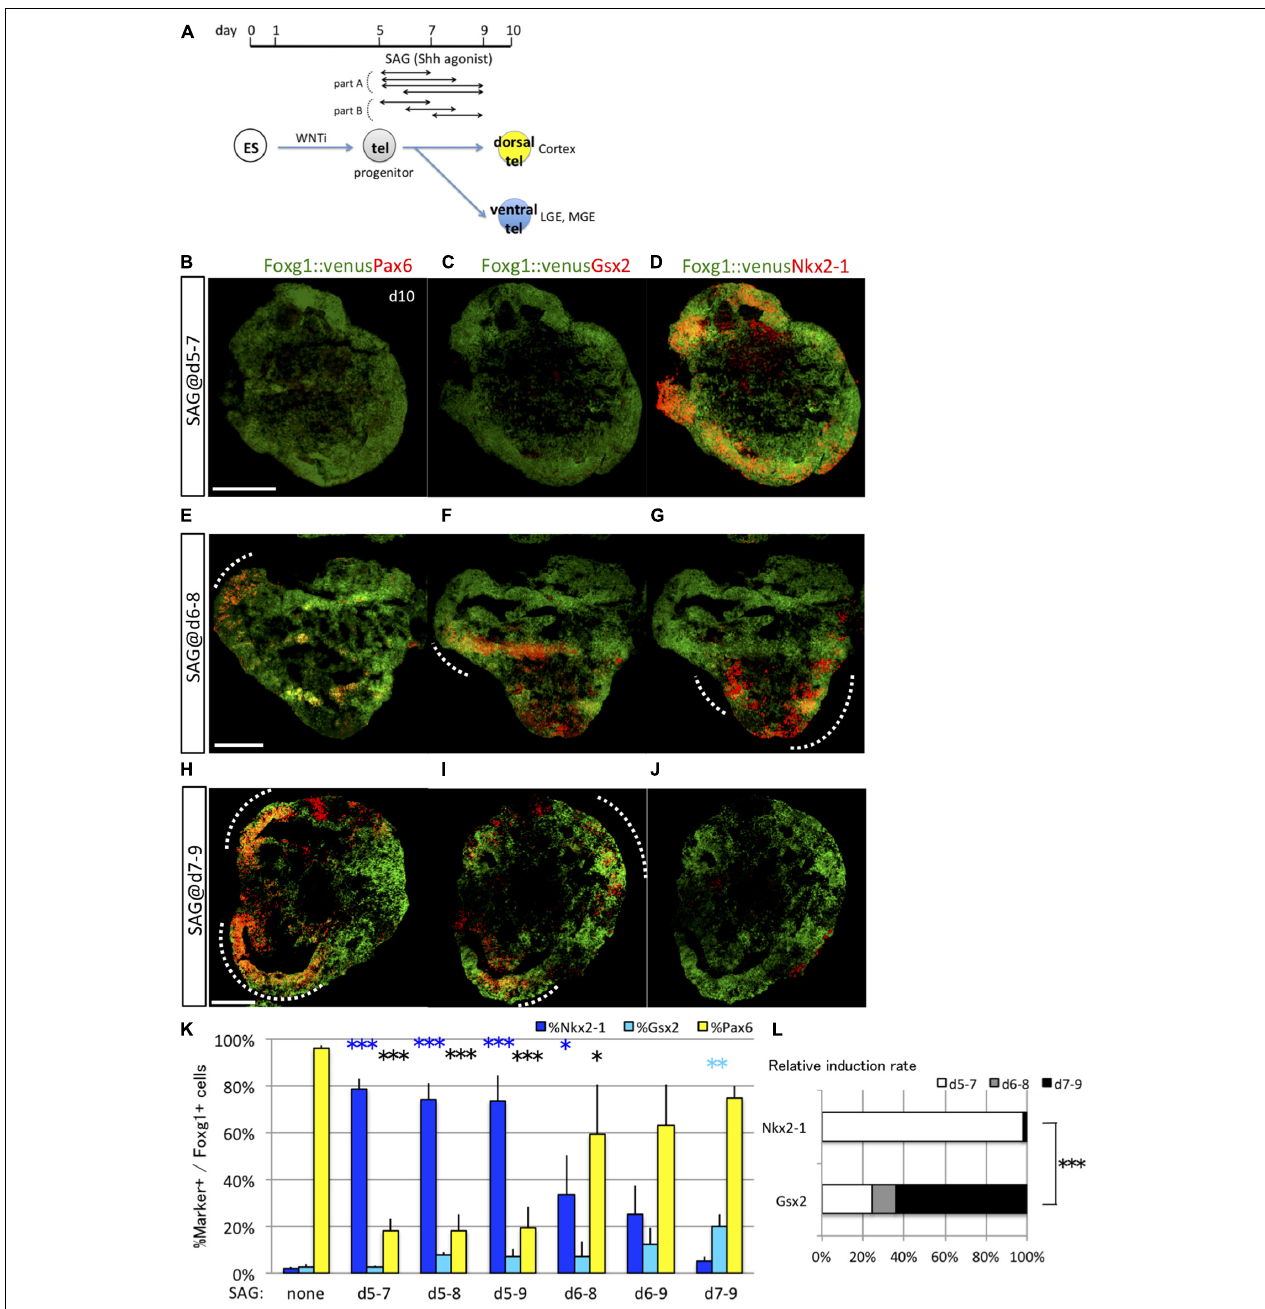
FIGURE 2 | Analyses of the optimal Shh signal time window for induction of ventral fates in telencephalic organoids. (A) Schematic of the differentiation strategy for dorsal and ventral telencephalon (tel) using the 3D culture model. Embryonic stem (ES) cells can be differentiated into lineages of the anterior telencephalon by Wnt inhibition (WNTi; anteriorization) and lineages of the ventral telencephalon by Shh signaling (ventralization). We determined the optimal time window of Shh signal exposure to induce ventral telencephalon using an Shh agonist (SAG). Cell aggregates (organoids) were analyzed to express the pan-telencephalic marker Foxg1 and subregional markers on day 10. (B–J) Fluorescence images of serial sections through Foxg1::venus (telencephalic) cell aggregates (green) co-immunostained for subregional markers (red) Pax6 (B,E,H) , Gsx2 (C,F,I) , and Nkx2-1 (D,G,J) . A dashed line indicates an area with dual Foxg1 + /subregional marker + cells. Scale bars, 200 µ m. (B–D) Aggregates cultured with 3-nM SAG during days 5–7 post-seeding expressed Nkx2-1 primarily. (E–G) Aggregates cultured with 3-nM SAG during days 6–8 expressed Pax6, Gsx2, and Nkx2-1. (H–J) Aggregates cultured with 3-nM SAG during days 7–9 expressed Pax6 and Gsx2 but little Nkx2-1. (K) Proportions (%) of subregional marker + cells among Foxg1 + cells; Pax6 + (yellow bars), Gsx2 + (cyan bars), and Nkx2-1 + (blue bars). “d5–7,” “d6–8,” “d7–9,” “d5–8,” “d6–9,” and “d5–9” indicate SAG exposure during days 5–7, 6–8, 7–9, 5–8, 6–9, and 5–9, respectively. “None” indicates the culture condition without SAG. (L) Differences in relative induction rate during days 5–7 (white bars), 6–8 (gray bars), and 7–9 (black bars) indicate that the fates of Nkx2-1 + and Gsx2 + cells are determined at different times, with the early time window optimal for inducing Nkx2-1 + cells and the late time window optimal for inducing Gsx2 + cells. Values expressed as mean ± standard error of the mean ( N = 3). ∗ P < 0.05, ∗∗ P < 0.01, ∗∗∗ P < 0.001.